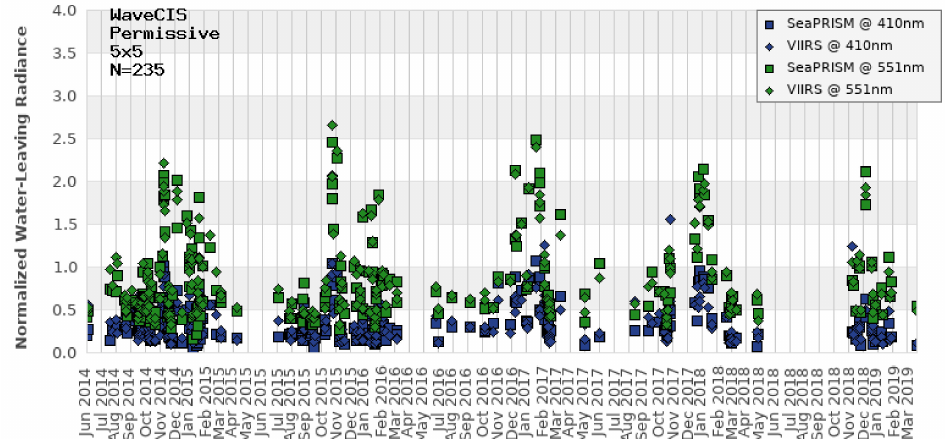
Figure 10. Time series of WaveCIS in situ and satellite match-ups, June 2014 through to May 2019. The highs in both sensors occur during winter time, with spring and summer lows. Also note data holidays caused by the instrument being calibrated or issues at the ground-truth